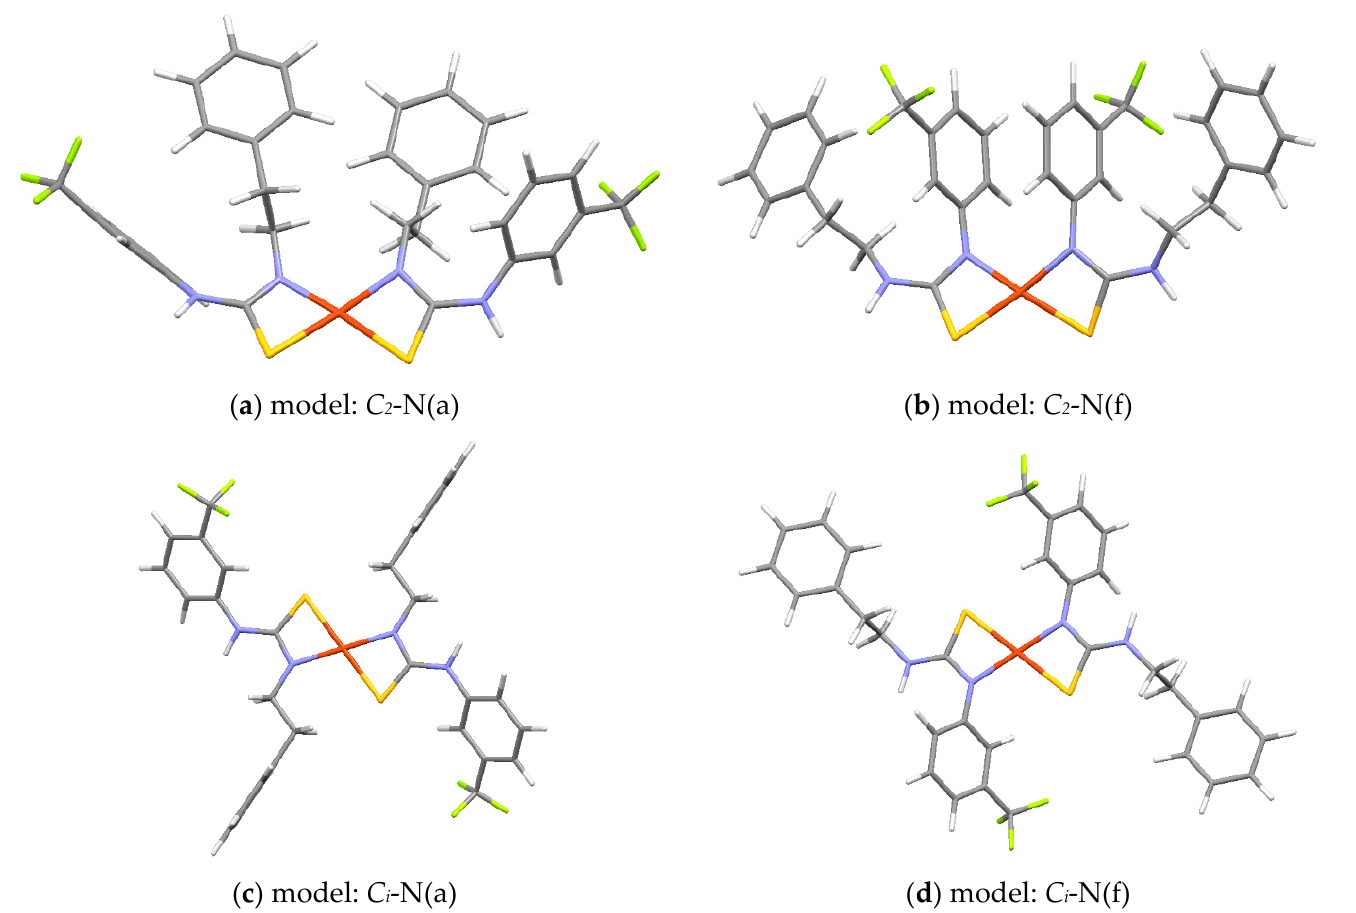
Figure 8. DFT optimized molecular structure of models of Cu1 with CuN 2 S 2 coordination sphere. The models are denoted by their point groups ( C 2 and C i ) and the type of N atom coordinating Cu: N(a) denotes nitrogen atom bond with the alkyl chain, and N(f) denotes nitrogen atom bonds with the trifluoromethylphenyl substituent.